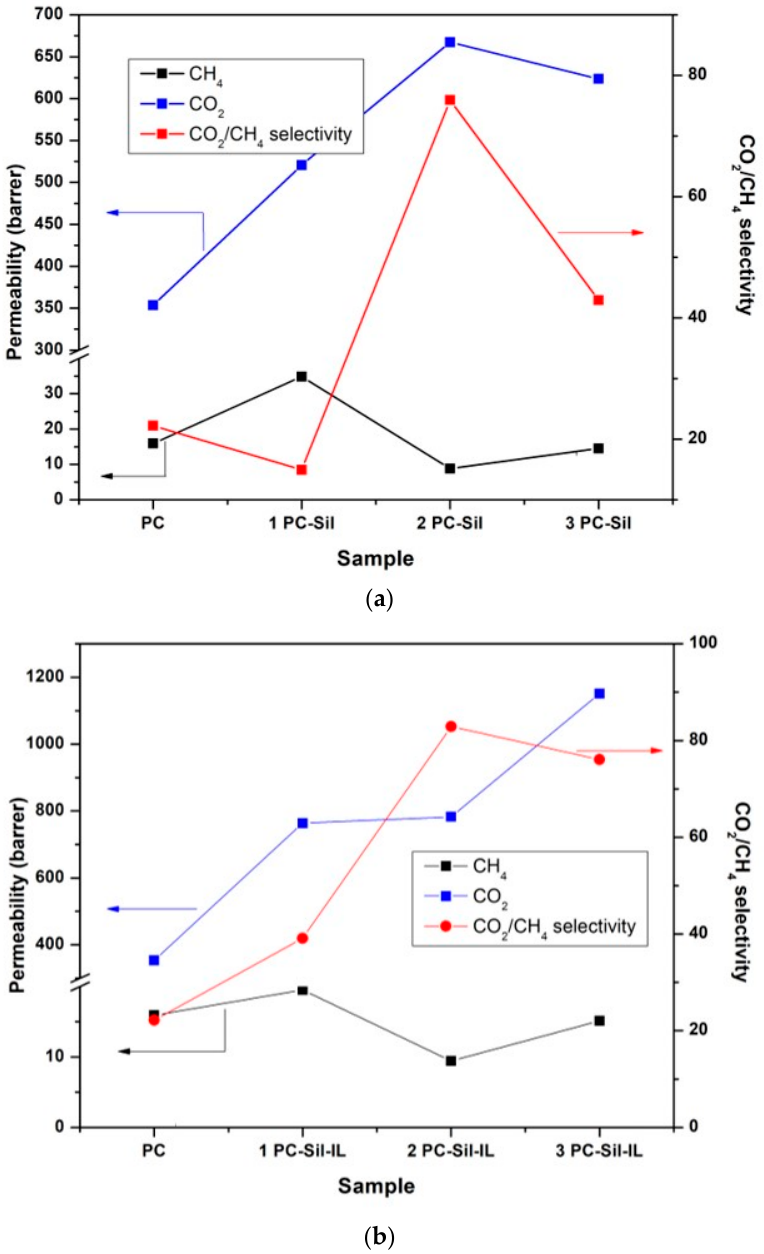
Figure 5. Separation performance of the prepared membranes in Barrer for ( a ) PC-Sil MMM, ( b ) PC-Sil-IL MMM at 2 bar feed pressure.